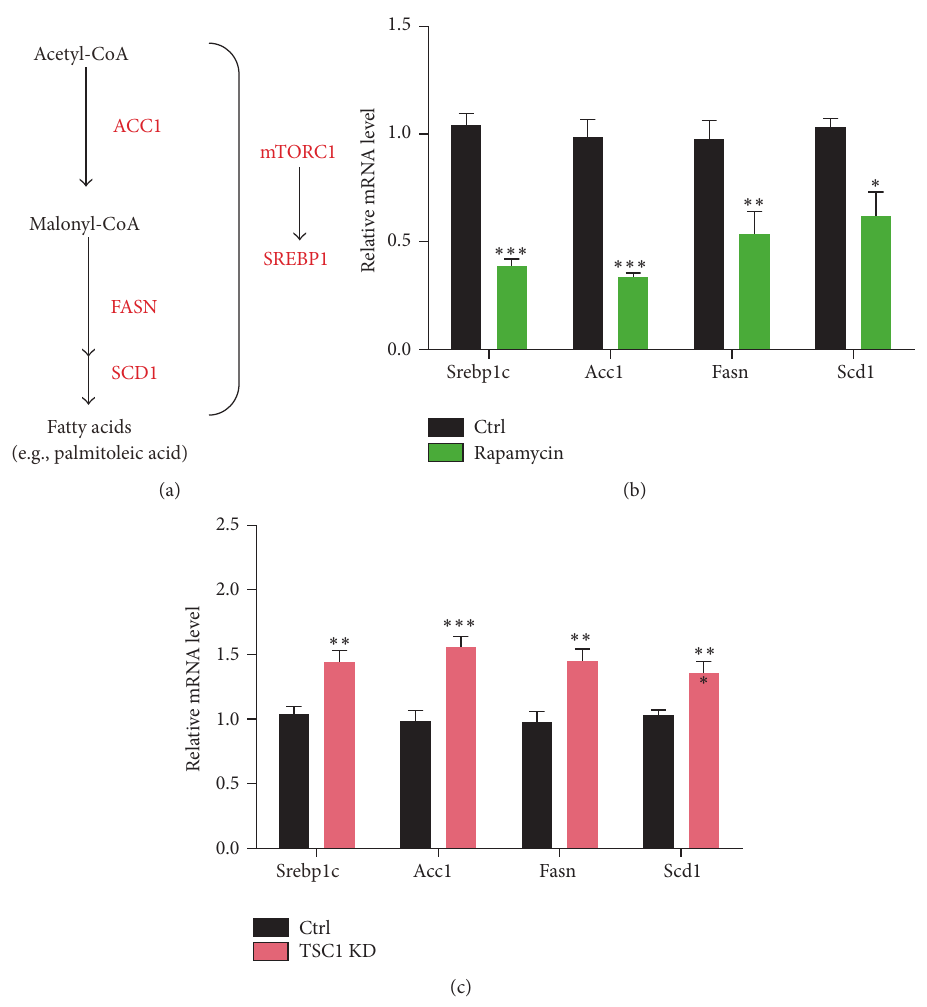
Figure 3: mTORC1 signaling regulates palmitoleic acid level through its de novo synthesis. (a) A model showing the de novo lipid synthesis in mammalian cells. mTORC1 mainly regulates gene transcriptions of Srebp1c, Acc1, Fasn , and Scd1 by SREBP1. (b) Real-time PCR results showed the decreased gene expressions of Srebp1c, Acc1, Fasn , and Scd1 in cells treated with rapamycin. Results are averages of three independent experiments. Data represent mean ± SEM. ∗ 𝑝 < 0.05 , ∗∗ 𝑝 < 0.01 , and ∗∗∗ 𝑝 < 0.001 . (c) Real-time PCR results showed the increased gene expressions of Srebp1c, Acc1, Fasn , and Scd1 in cells by TSC1 KD. Results are averages of three independent experiments. Data represent mean ± SEM. ∗∗ 𝑝 < 0.01 and ∗∗∗ 𝑝 < 0.001